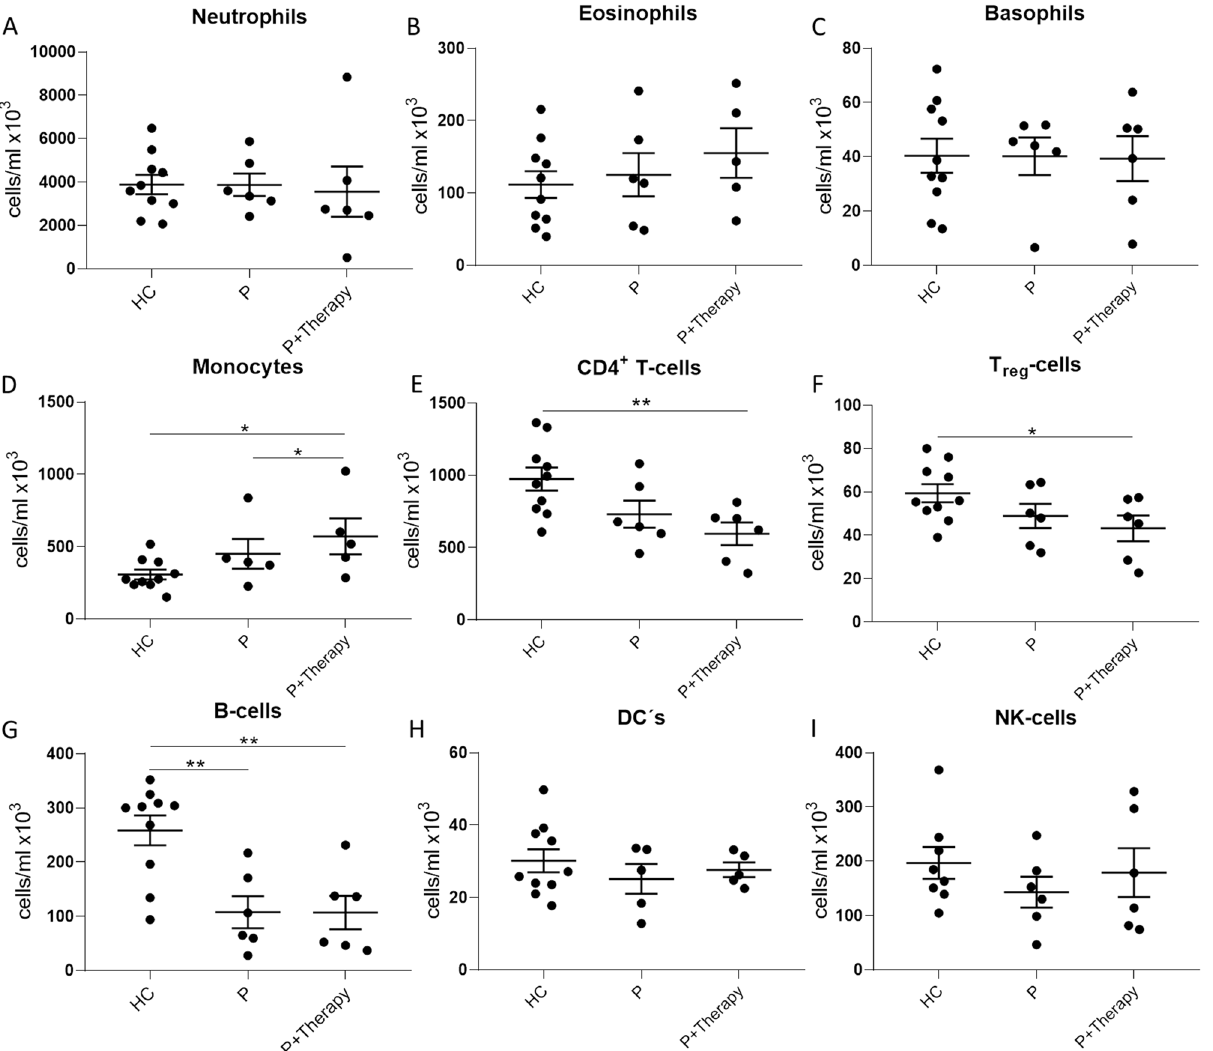
Figure 1. Immunophenotyping analysis of peripheral blood cells from healthy controls and patients. Whole blood samples from healthy controls without any treatment (HC), from OA patients before treatment (P), and from the same patients after the second therapy treatment (P + Therapy) were analysed. The composition of ( A ) neutrophils, ( B ) eosinophils, ( C ) basophils, ( H ) dendritic cells, and ( I ) natural killer cells showed no modulation because of therapy treatment and also no significant differences between healthy controls and patients. CD4 + T-cells ( E ) and T reg -cells ( F ) revealed a significant decrease in cells after second therapy treatment compared with healthy controls but not with OA patients before treatment. ( G ) B cells were significantly decreased in OA patients in general and ( D ) monocytes showed a significant increase after treatment in OA patients also compared to healthy controls. Results are given as mean ± SEM; T-test, *p < 0.5; **p < A significant decrease in the concentration of CD4 + T cells after the second therapy treatment (595.2 ± 77.8 × 10 3 cells/ml) compared with healthy controls (973.9 ± 79.2 × 10 3 cells/ml) (Fig. 2E) can be seen. Like CD4 + T cells, T reg cells showed a significant decrease when comparing the treatment group (43.2 ± 5.9 × 10 3 cells/ ml) with the subject group (59.3 ± 4.1 × 10 3 cells/ml) (Fig. 1F). B cells (Fig. 1G) were significantly decreased in both cells/ml). Only one cell type showed a significant difference between the OA group and the therapy group. Monocytes (Fig. 1D) were increased with a significant difference between OA group (450.4 ± 102.3 × 10 3 cells/